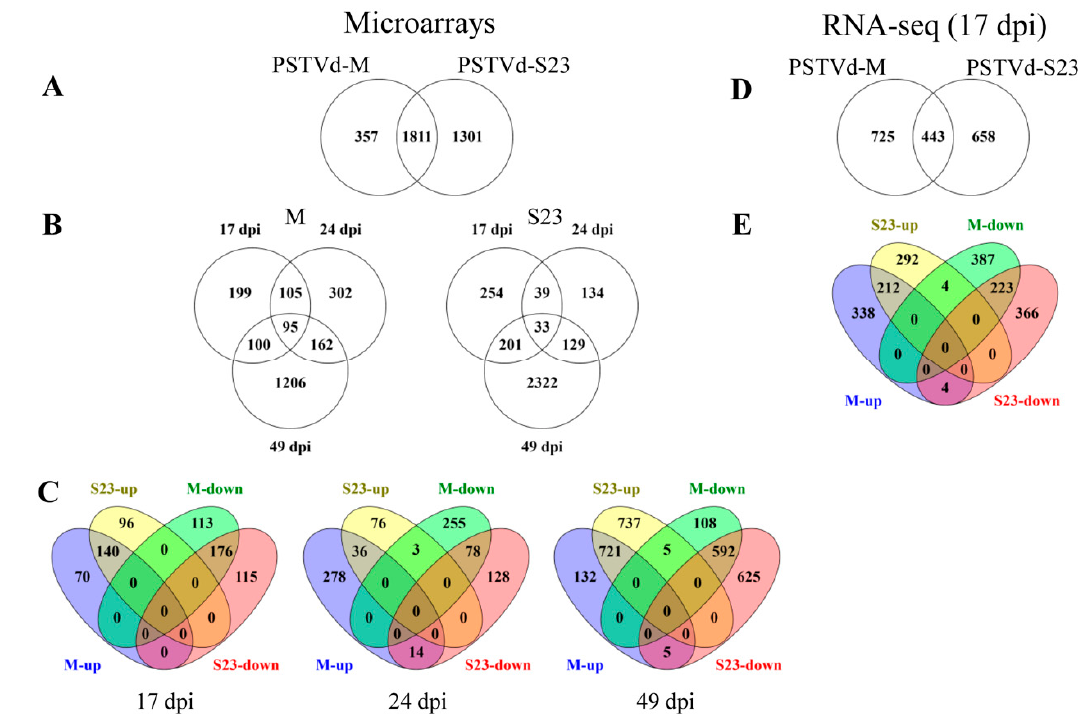
Figure 2. The number of differentially expressed genes (DEGs) identified in microarray ( A , B , C ) and RNA-seq analysis ( D , E ). Venn diagrams display the distribution of: ( A ) Total DEGs in M- and S23-infected roots, ( B ) and at 17, 24 and 49 dpi. ( C ) Up- and down-regulated genes observed at the indicated time points. ( D ) Total DEGs at 17 dpi. ( E ) Up- and down-regulated genes at 17 dpi.